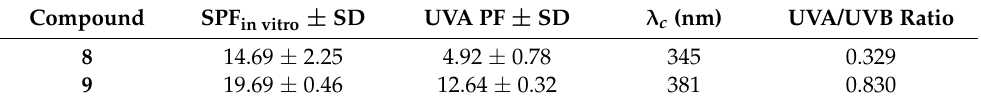
Table 3. Photoprotective activity of compounds 8 and 9 obtained in 12.5% ( w / w ) cosmetic formulation.